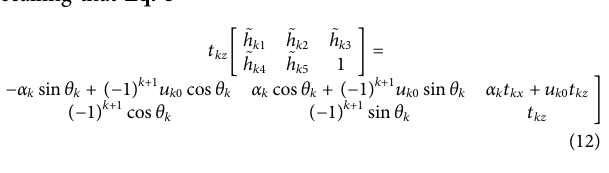
TABLE 1 | Calibration results of stereo line-scan cameras.